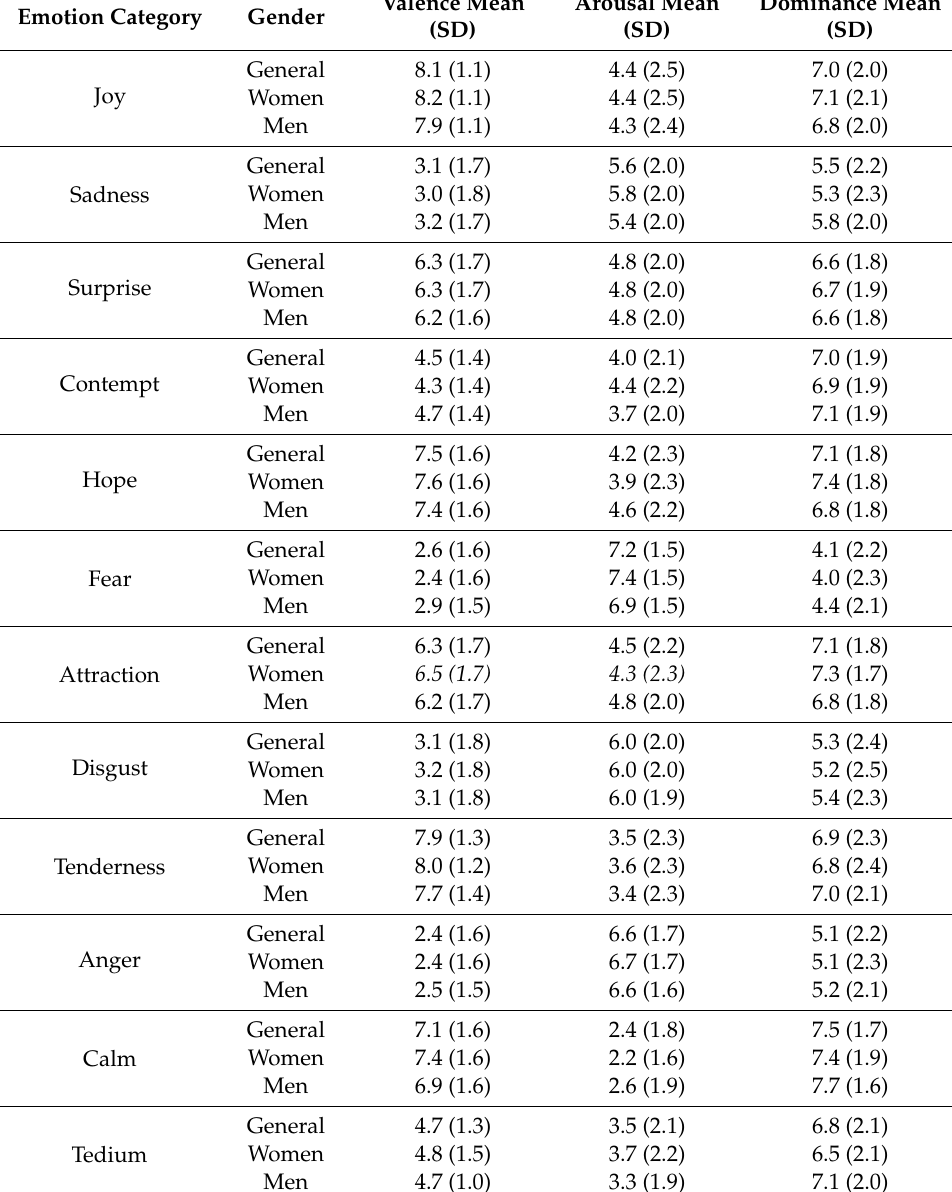
Table 5. Self-report responses per emotion reported category, mean (standard